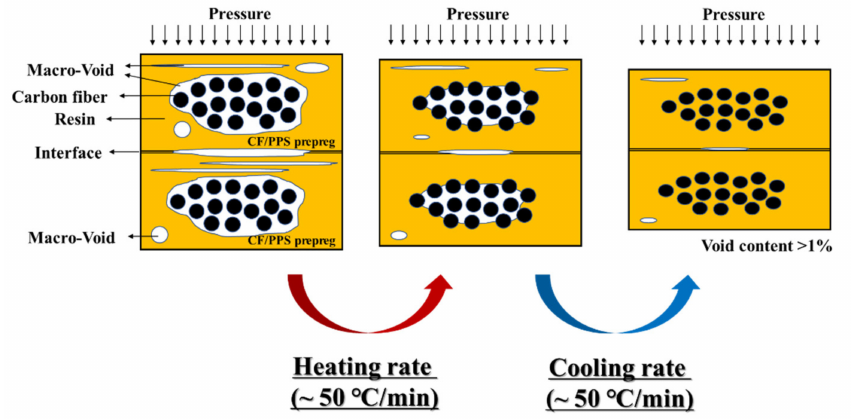
Figure 2. Schematic of the CF/PPS prepreg consolidation process.